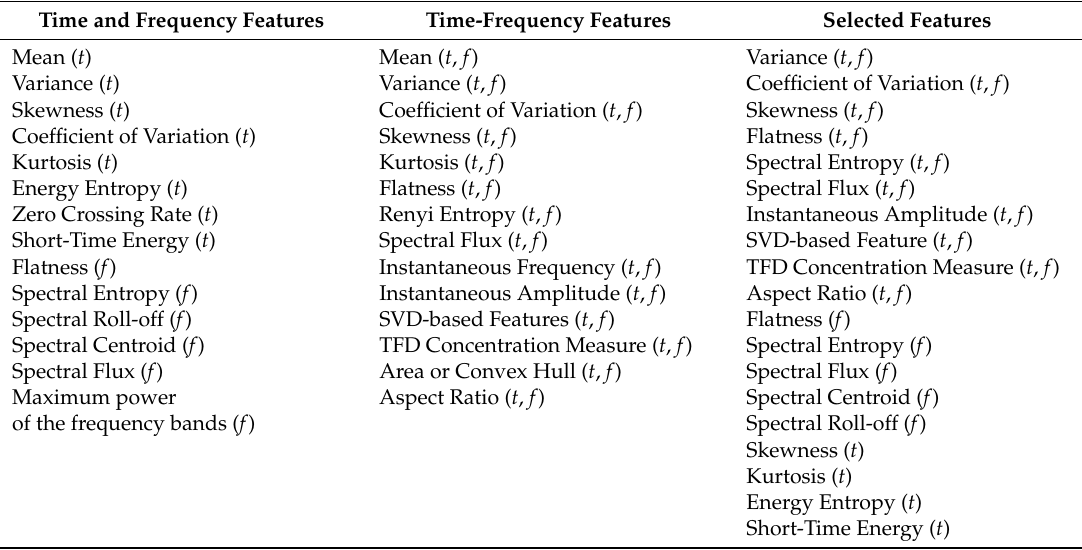
Table 3. Ranking of the t -, f - and ( t , f )-domain features based on mutual information